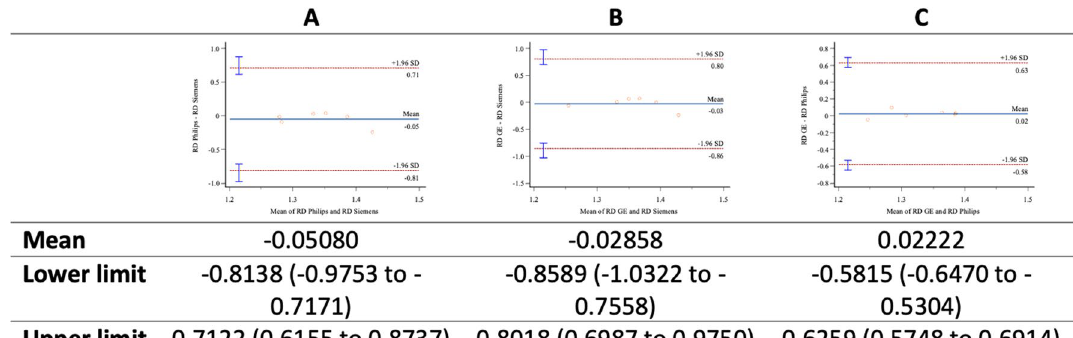
Fig. 5 RD- A : Philips versus Siemens; B GE versus Siemens; C GE versus